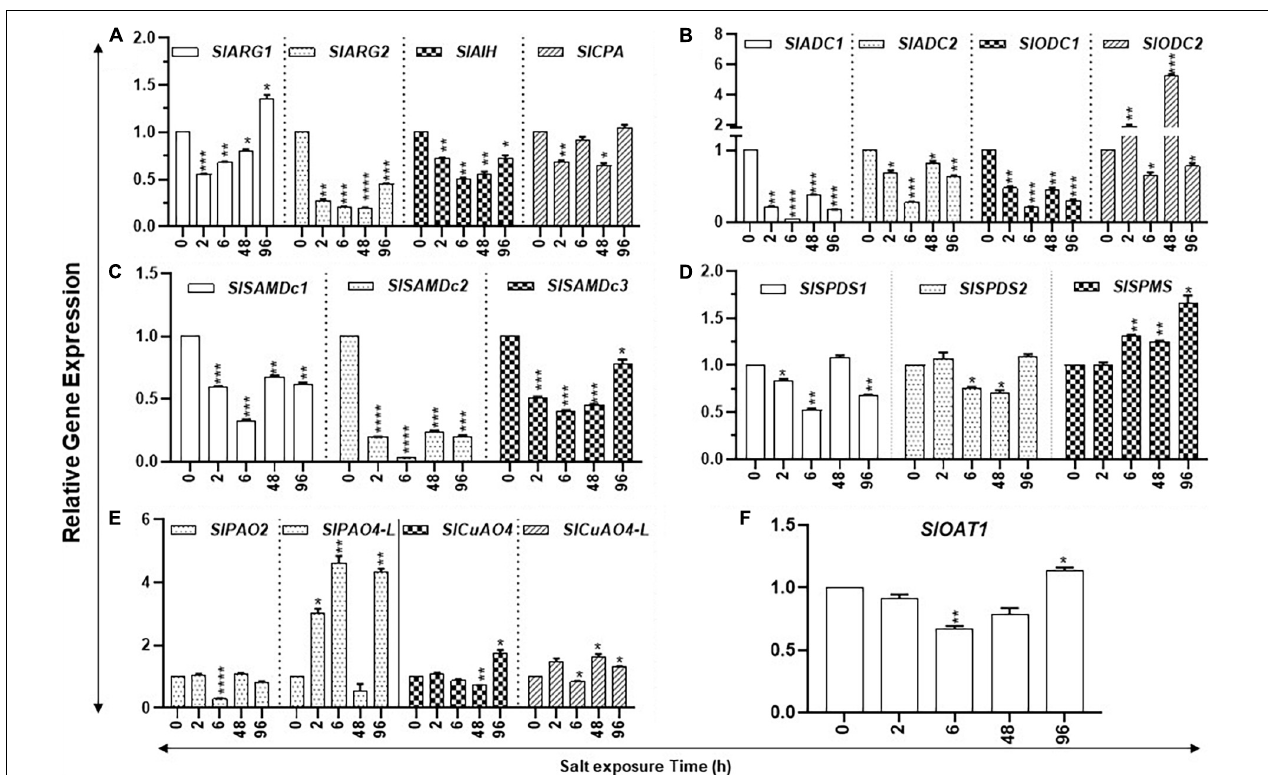
FIGURE 6 | Kinetics of salt stress-induced expression of PA metabolic pathway genes in tomato leaves. Total RNAs were extracted from tomato leaves harvested after salinity stress for 0, 24, 48, and 96 h. The steady state levels of transcripts of various PAs biosynthesis and catabolism genes were determined by qRT-PCR as described in Materials and Methods. Genes included were those of PUT biosynthesis ( SlARG1, 2 , SlADC1, 2 SlODC1, 2, SlAIH , and SlCPA ), SPD, and SPM biosynthesis ( SlSAMDc1, 2, 3, SlSPDS1, 2 , and SlSPMS ); and catabolism ( SlPAO2 and SlPAO4-Like; SlCuAO4 and SlCuAO4-like ) pathways, respectively. SlOAT1 expression was assessed for the flow of ornithine toward the proline pathway. Mean data points and SE were derived from a minimum of three biological replicates. SlUB13 and SlTIP41 were used as reference genes. Other details were the same as in Figure 1 . **** indicates significance at p -value of <